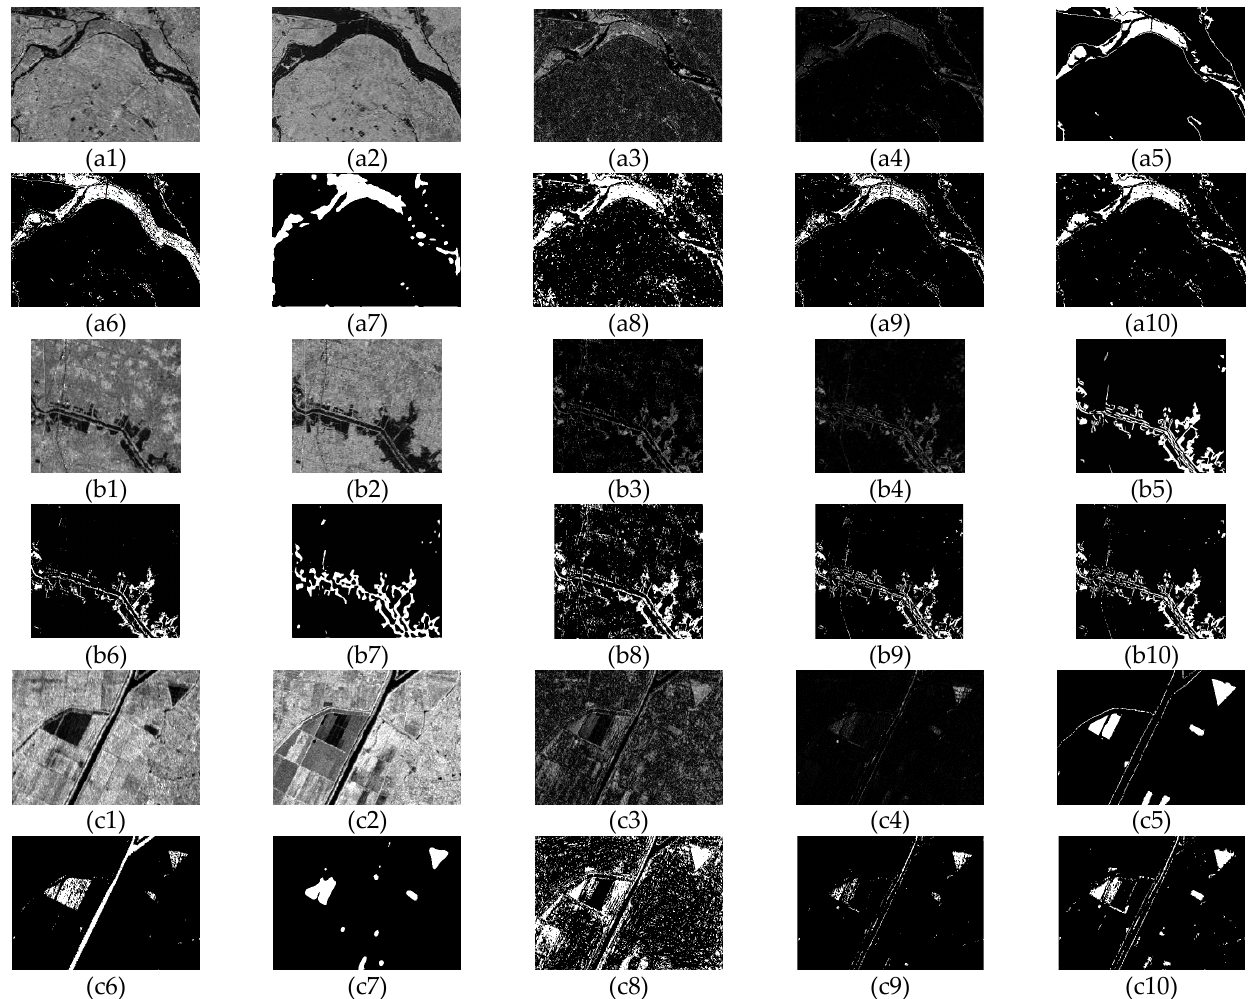
Figure 4. GaoFen-3 SAR image change detection results. ( a1 ) – ( a9 ) Region A. ( b1 ) – ( b9 ) Region B. ( c1 ) – ( c9 ) Region C. ( a1 ) – ( c1 ) Pre-event images. ( a2 ) – ( c2 ) Post-event images. ( a3 ) – ( c3 ) Subtraction images. ( a4 ) – ( c4 ) Ratio images. ( a5 )-( c5 ) Reference images. ( a6 ) – ( c6 ) Change maps resulted from the ratio kernel-based SVM. ( a7 ) – ( c7 ) Change maps resulted from CNN with ratio images. ( a8 ) – ( c8 ) Change maps resulted from KGC with subtraction images. ( a9 ) – ( c9 ) Change maps resulted from KGC with ratio images. ( a10 ) – ( c10 ) Change maps resulted from MKGC.